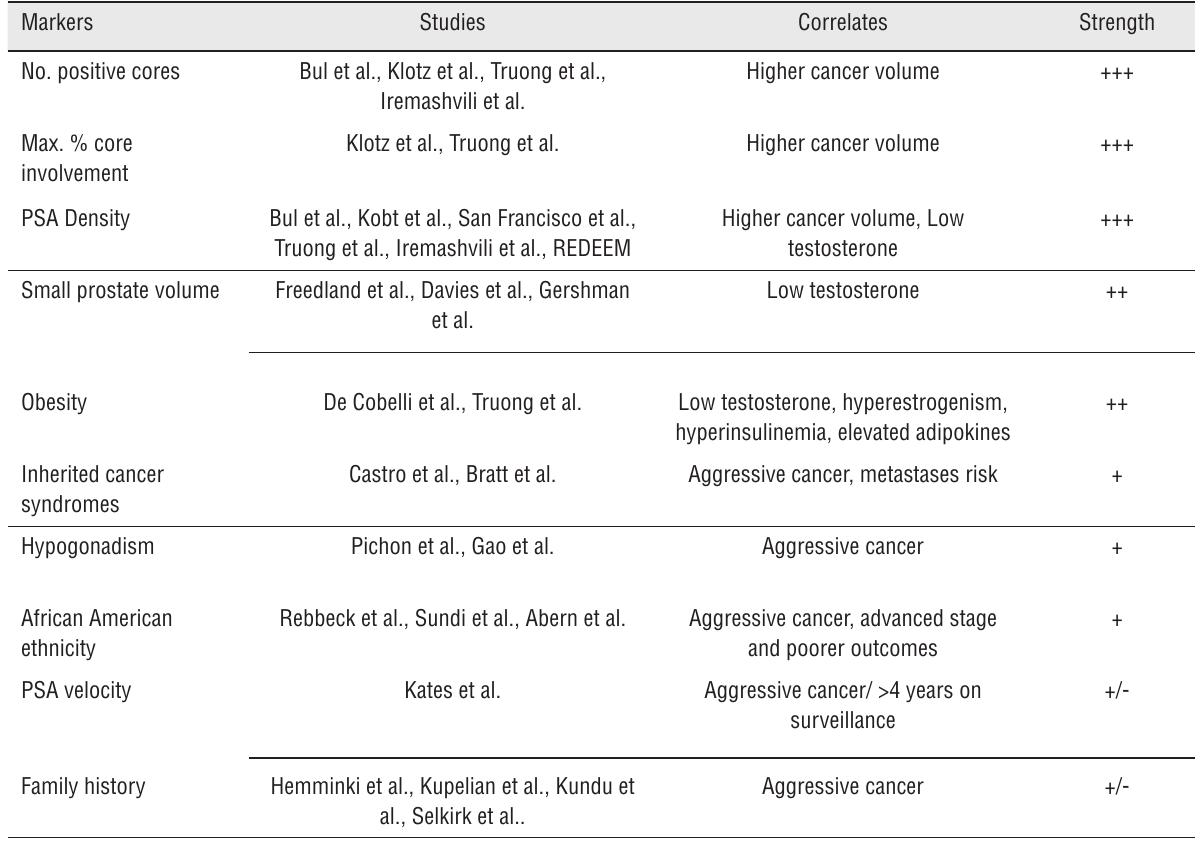
Table 2 - clinicopathologic predictors of upgrading gleason score (>6) during active surveillance from published studies.